Question: Which kind of chart has been used to present this data?
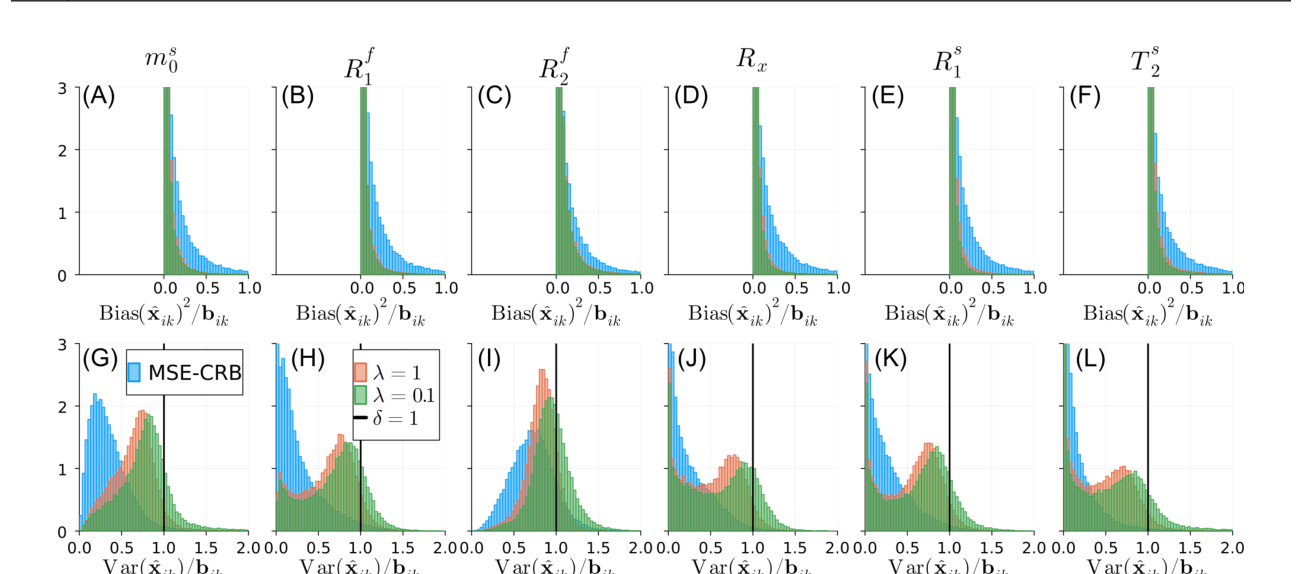
Answer: histogram